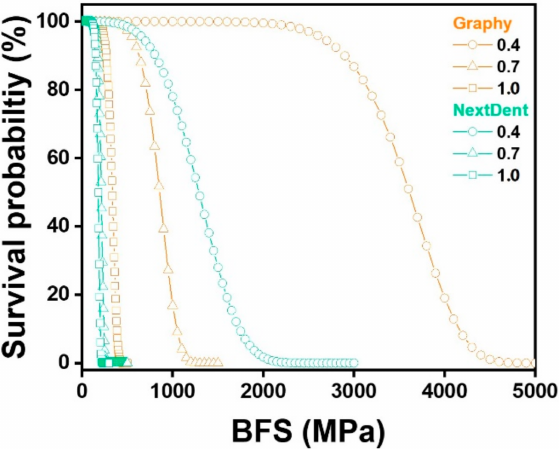
Figure 6. Weibull survival probability based on biaxial flexural strength (BFS) for thicknesses 0.4, 0.7, and 1.0 mm for Graphy and NextDent